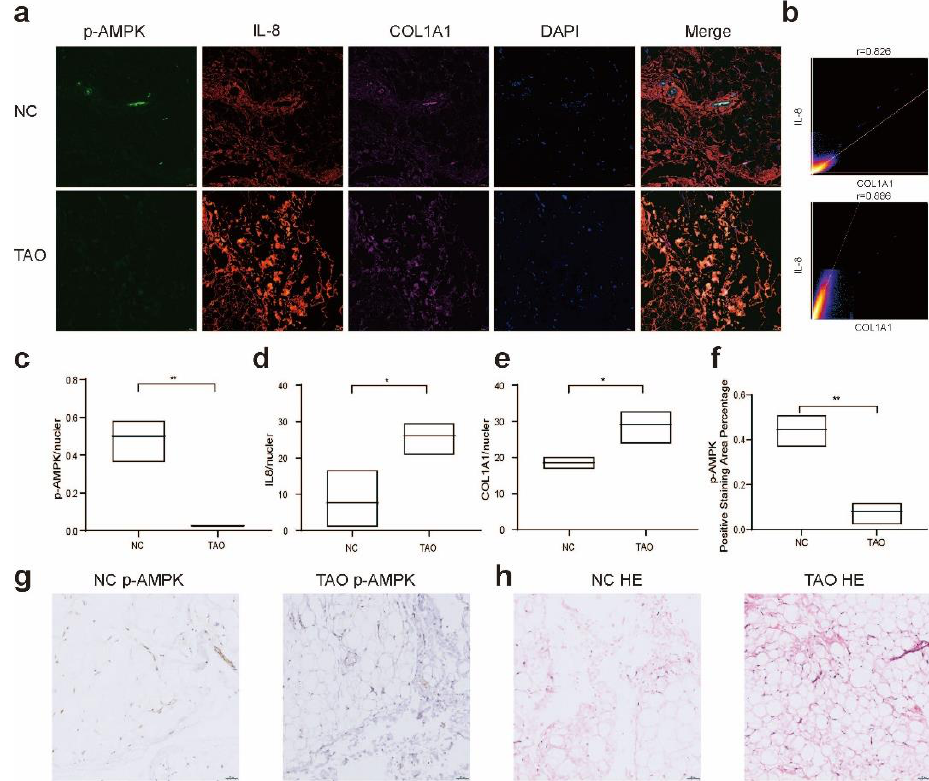
Figure 1. Alterations in AMPK activity in TAO orbital connective tissue. ( a ) Four-color IF analysis showing IL-8 (red), p-AMPK (green), COL1A1 (purple), and nuclei (blue) in the connective tissue of TAO and NC samples. Colocalization of p-AMPK, inflammation and fibrosis markers in orbital tissues of different populations. Scale bar, 50 µm. ( b ) Scattergrams indicate the fluorescence intensity and Pearson’s correlation (r) of IL-8 and COL1A1 in the image in ( a ). ( c – e ) Ratio of the fluorescence intensity of p-AMPK, IL-8, and COL1A1 to nuclei. ( f ) Average optical density (AOD) of p-AMPK in each group shown in ( g ). ( g , h ) DAB staining of p-AMPK and HE staining of tissue in the TAO and NC groups. Scale bar, 50 µm. n = 3 (control), n = 3 (TAO) for all. * p < 0.05 ,** p < 0.01 (unpaired t test).